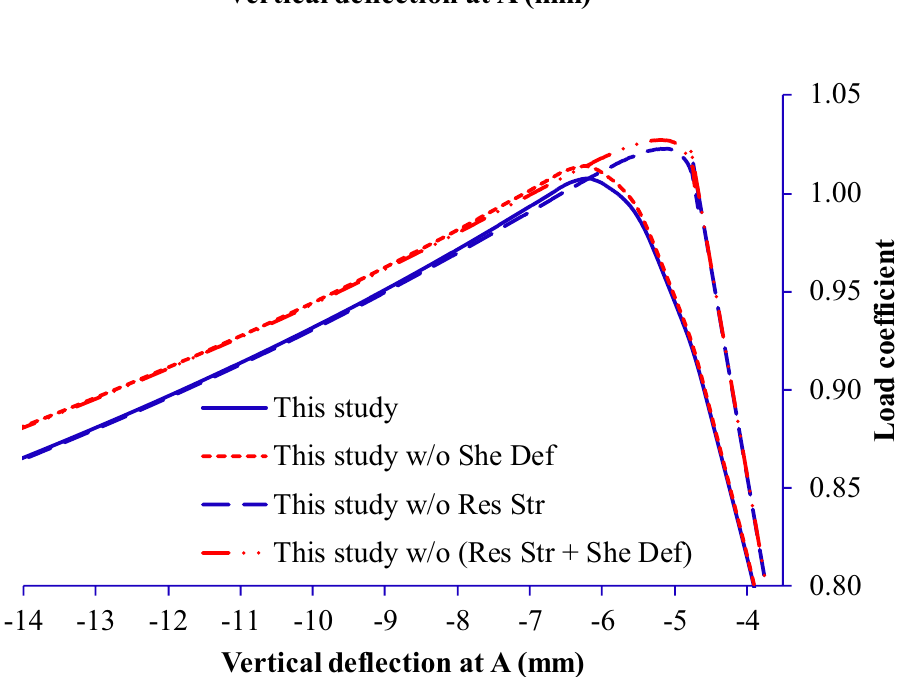
stresses are much smaller than those of case 1 and 2 with the effect of residual stresses. The post-collapse load curves of horizontal deflection at node A for four cases are matched together, as plotted in Fig. 6. In addi- tion, from Figs. 8 and 9, the post-collapse load curves of vertical deflection and rotation at node A for cases 1 and 3 are overlapped, and those for cases 2 and 4 are also overlapped. As shown in Figs. 7 and 8, shear deformation